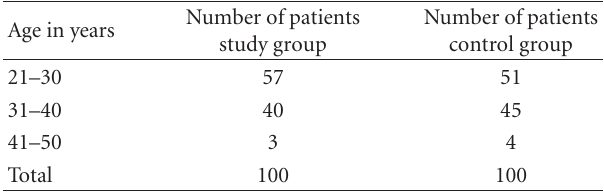
Table 1: Age distribution of patients in study and control group.